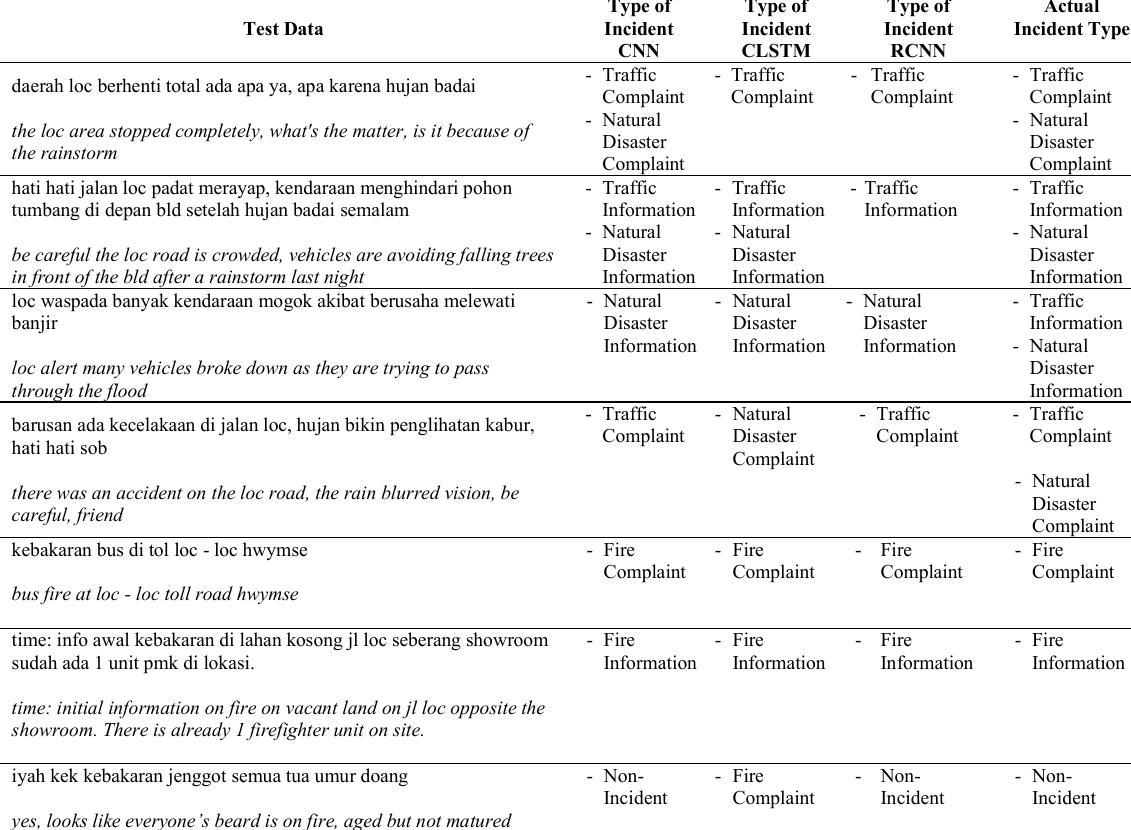
TABLE 7 T HE R ESULT OF T HE C LASSIFICATION C OMPARISON